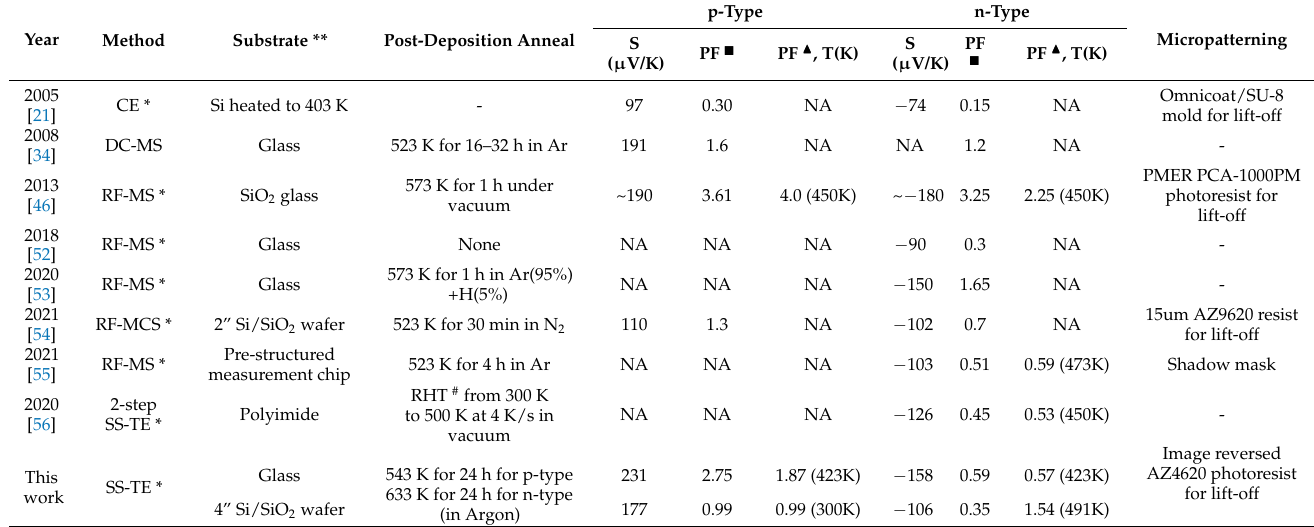
Table 4. Comparison of this work with other studies on near room temperature deposition of Bis- muth Telluride thin films using evaporation and sputtering based methods.